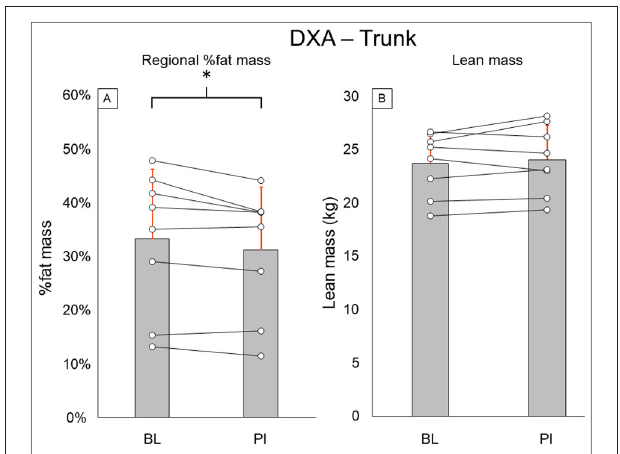
FIGURE 2 | Total body DXA results for regional % fat mass (A) and lean mass (B) . Gray bars represent group averages (red lines showing SD), with dots connected by lines representing individual participants and their changes from baseline to post-intervention measurements. DXA, dual-energy x-ray absorptiometry; BL, baseline; PI, post-intervention. *Significant to P < 0.05.